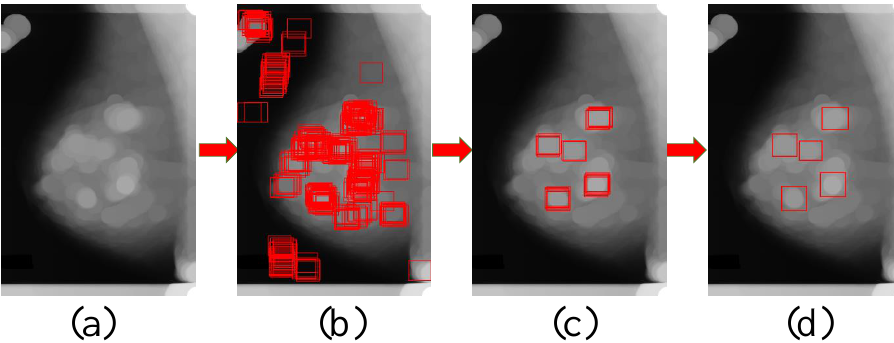
Figure 7. Process of breast mass candidate bounding box generation. Where ( a ) is the processed image using the mathematical morphology method, and ( b ) shows the matching results of suspected regions using the image template matching method with our breast mass image template on image ( c , d ) contains fewer suspected regions with a higher matching degree.